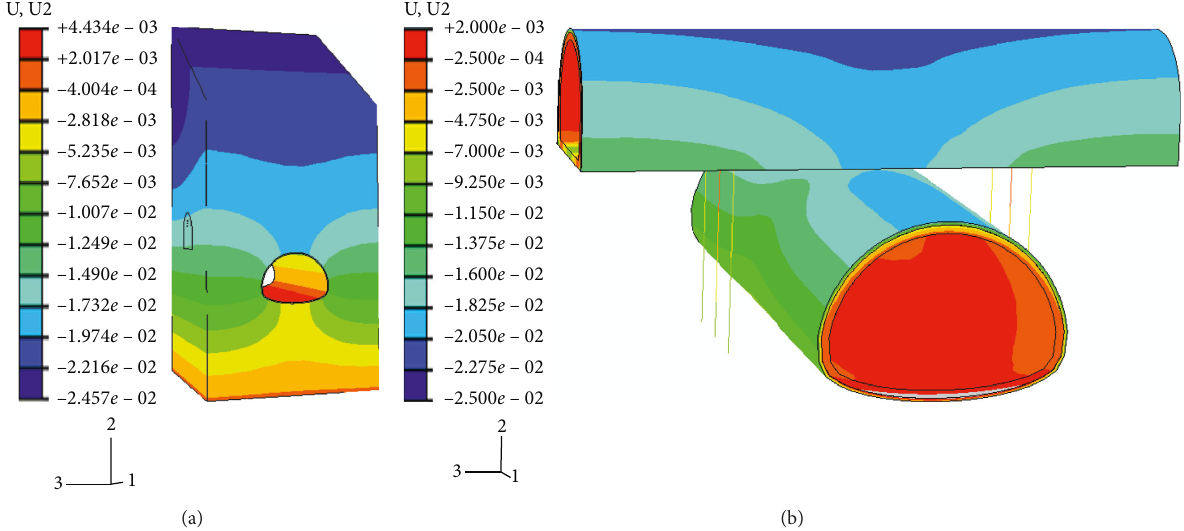
Figure 16: Vertical displacement distribution of Jia Hua Tunnel Left Line (unit: m).